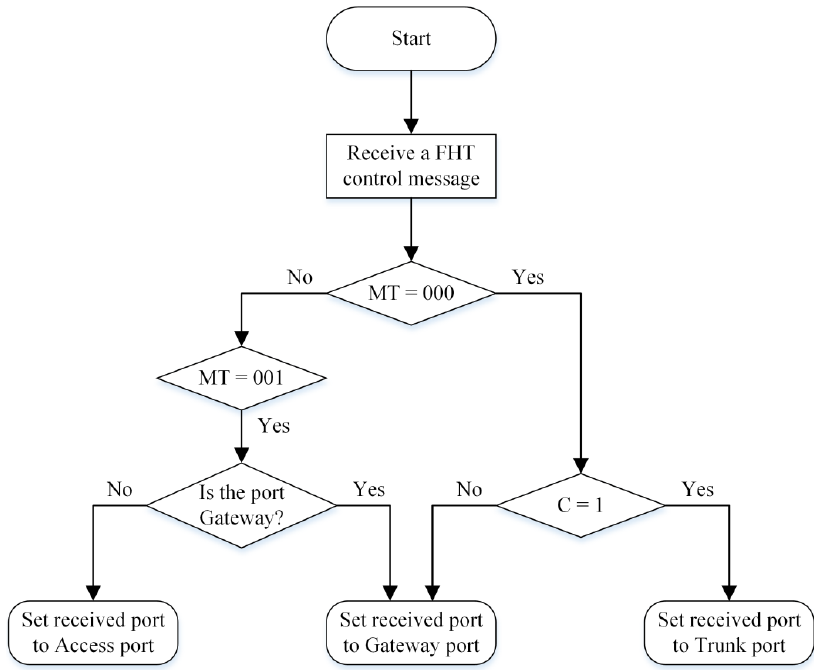
Figure 7. The process of setting port types for a QuadBox